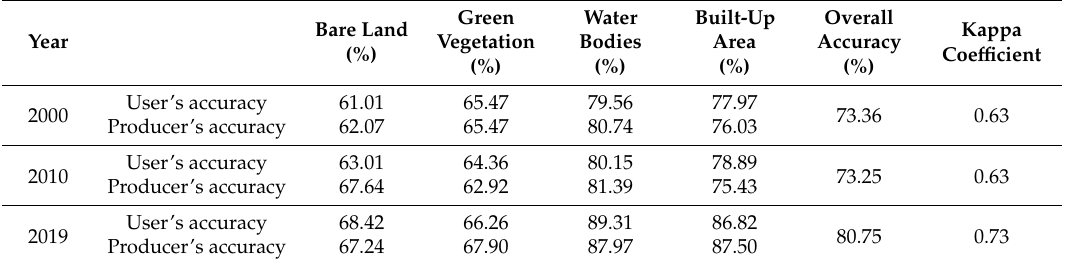
Table 2. Land-cover classification accuracy for selected